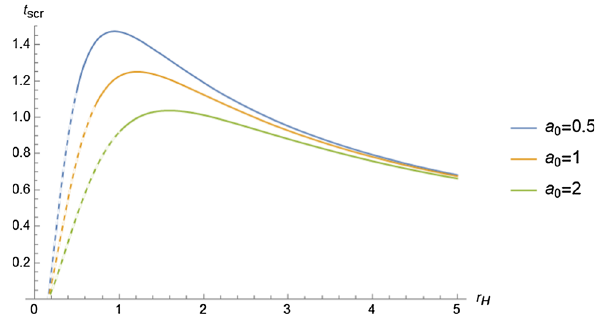
Fig. 12 The scrambling time as a function for the radius at a 0 = 0 . 5 , 1 , 2. The dotted line represents the unstable small black hole